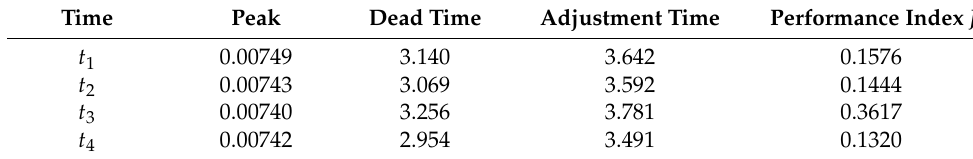
Figure 11. Residual at four moments. Table 1. Comparison of indicators at four moments .